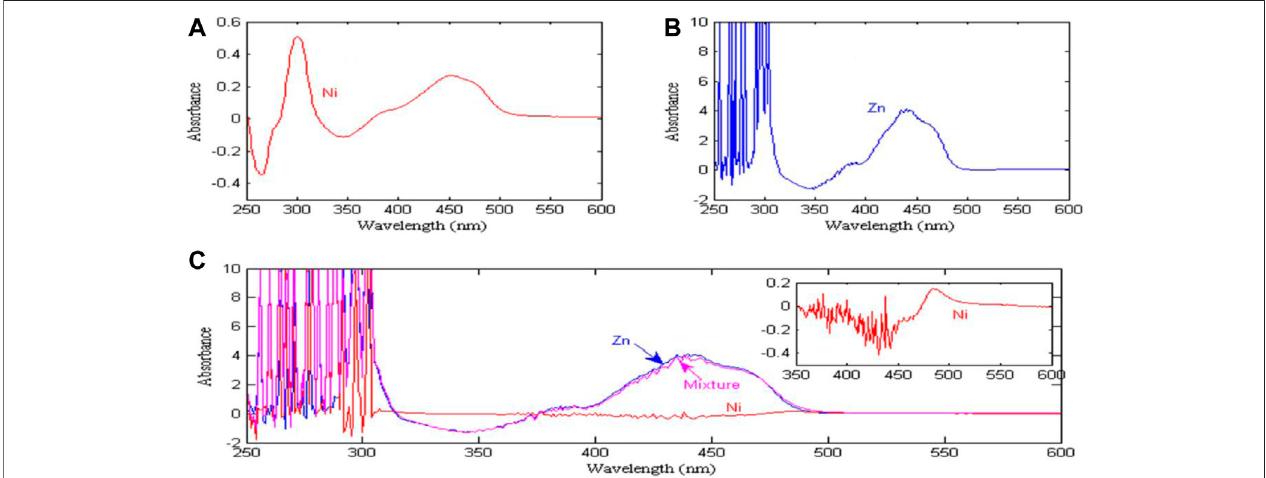
FIGURE 2 | Absorption spectra of zinc and nickel. (A) Absorption spectra of pure nickel solution; (B) Absorption spectra of pure zinc solution: Show results in wavelength range from 375 nm to 600 nm and Absorbance range from 0 to 6 (never below 0); (C) Absorption spectra of zinc, nickel and their mixtures: Show results in wavelength range from 300 nm to 600 nm and Absorbance range from 0 to 6 (never below 0); Show results in wavelength range from 475 nm to 600 nm and Absorbance range from 0 to 0.2 (never below 0).